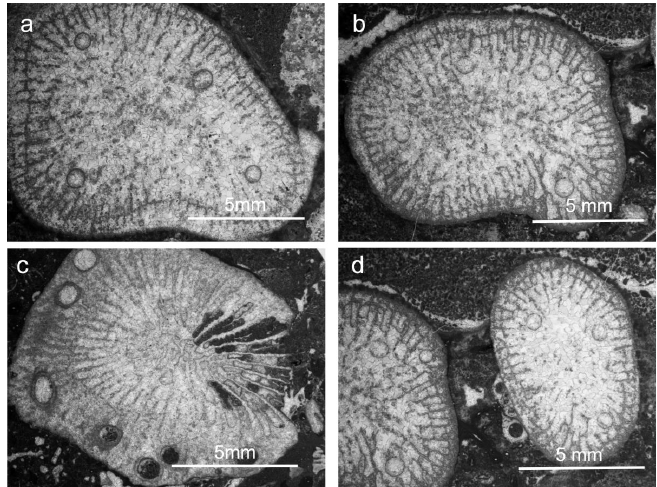
Figure 2 Figure 2. Coral–worm association in the Štramberk-type limestones (Poland). ( a , b ) Thin-walled tubes (Type 1) in the coral calyx, transverse section. ( c ) Relatively thin wall of tubes of Type 2 in the peripheral region of the calyx, transverse section. ( d ) Thin-walled tubes in the calyx; serpulid tubes attached to the exterior of the corallite, transverse section. ( a , b , d ) —Calamophylliopsis flabellum,